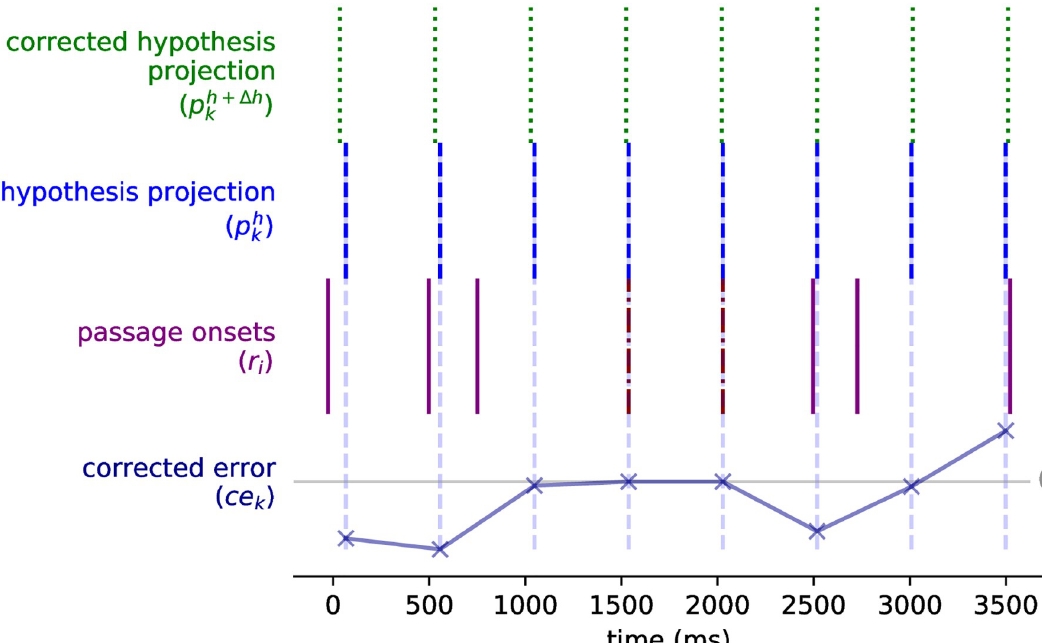
Fig 6. Example of hypothesis correction on a complex rhythm. The figure repeats all three elements from Fig 5: input ( r i ), original hypothesis projection ( p h ) and corrected hypothesis projection ( p h þ D h ). The input is now a complex rhythm where not all hypothesis k k projection times have a corresponding onset time (at 1000 and 3000 ms). The correction is now performed using the corrected prediction error ( ce ) for each projection event. The corrected prediction error is shown, at the bottom of the figure. The hypothesis k projection lines ð p h Þ are extended downwards to match with correction error score. The corrected error is larger when the error is k larger but goes back to zero when there is no onset event close to the projection event.